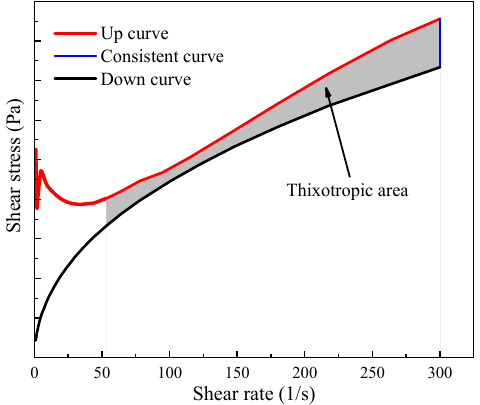
Figure 3. Thixotropic area of all pastes.